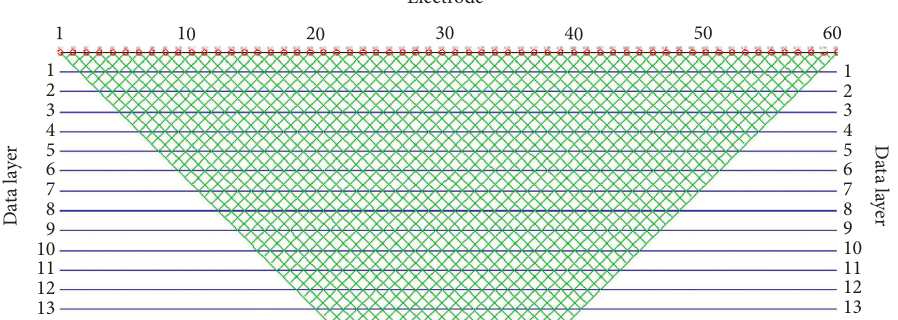
Figure 2: Schematic diagram of high-density direct current method.